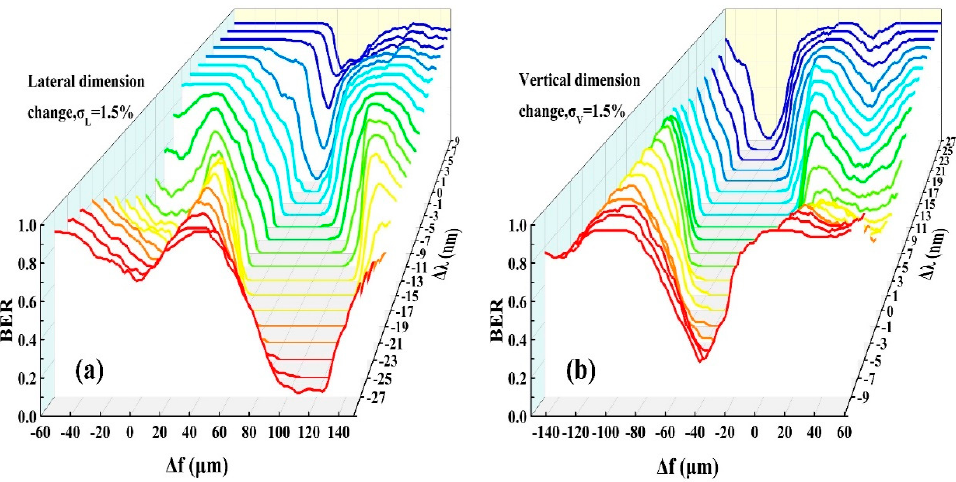
Figure 10. The compensation effects of the combination compensation method for ( a ) the lateral dimension change condition ( σ L = 1.5%) and ( b ) the vertical dimension change condition ( σ V = 1.5%).